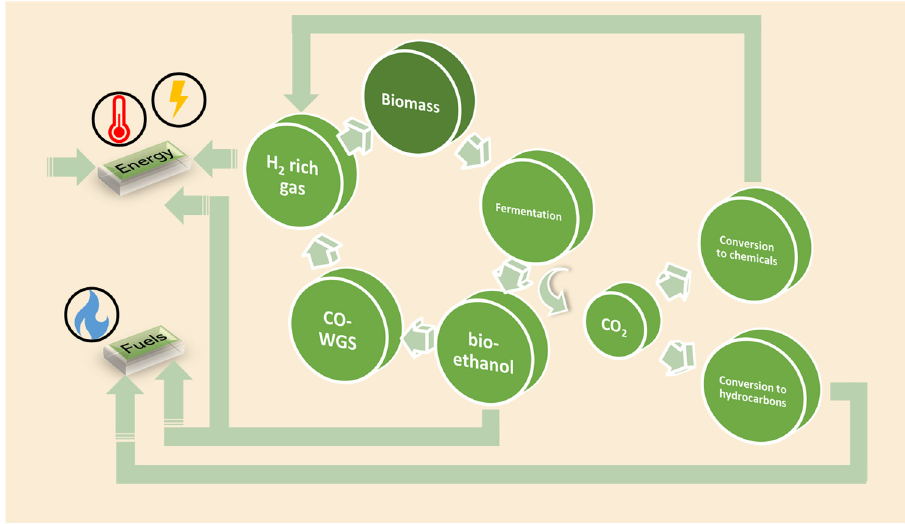
Figure 2. From biomass to hydrogen and fuels: schematic overview.